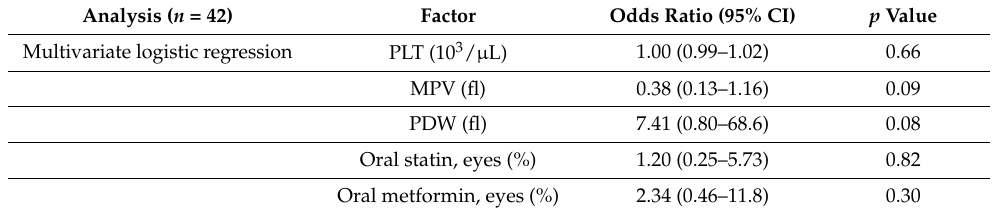
Table 4. Multivariate logistic regression analyses of risk factors associated with PVI.